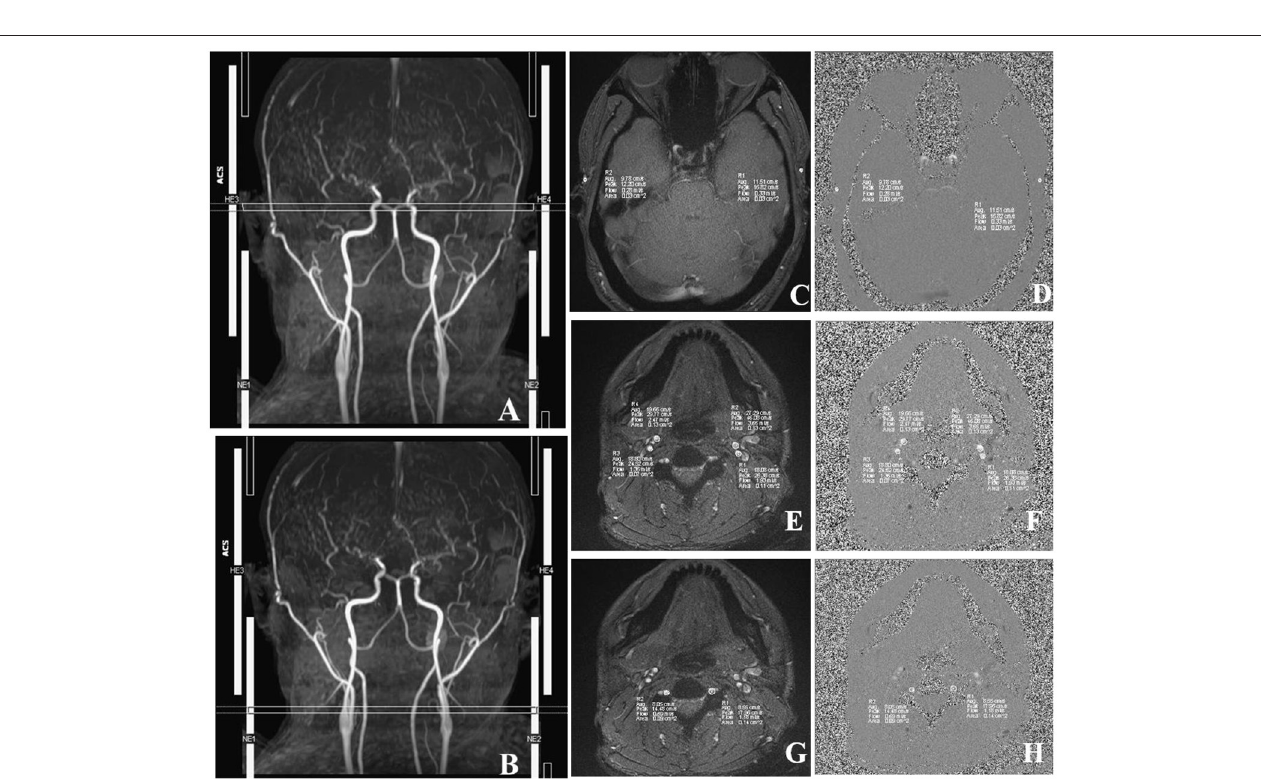
FIGURE 3 | Images acquired in a representative subject illustrate the details of MRI acquisition location and measurement of superficial temporal (STA), internal carotid (ICA), external carotid (ECA), and vertebral (VA) arteries. (A) Time-to-flight (TOF) image shows the location and slice position of STA. (B) TOF image shows the location and slice position of ICA, ECA, and VA. (C) The magnitude image; (D) The phase image; R 1/ R 2, left/right STA. (E) The magnitude image; (F) The phase image; R 3/ R 4, right ICA/ECA. (G) The phase image; (H) The magnitude image, R 1/ R 2, left/right VA. The circles in R 1– R 4 illustrate the voxels with maximal